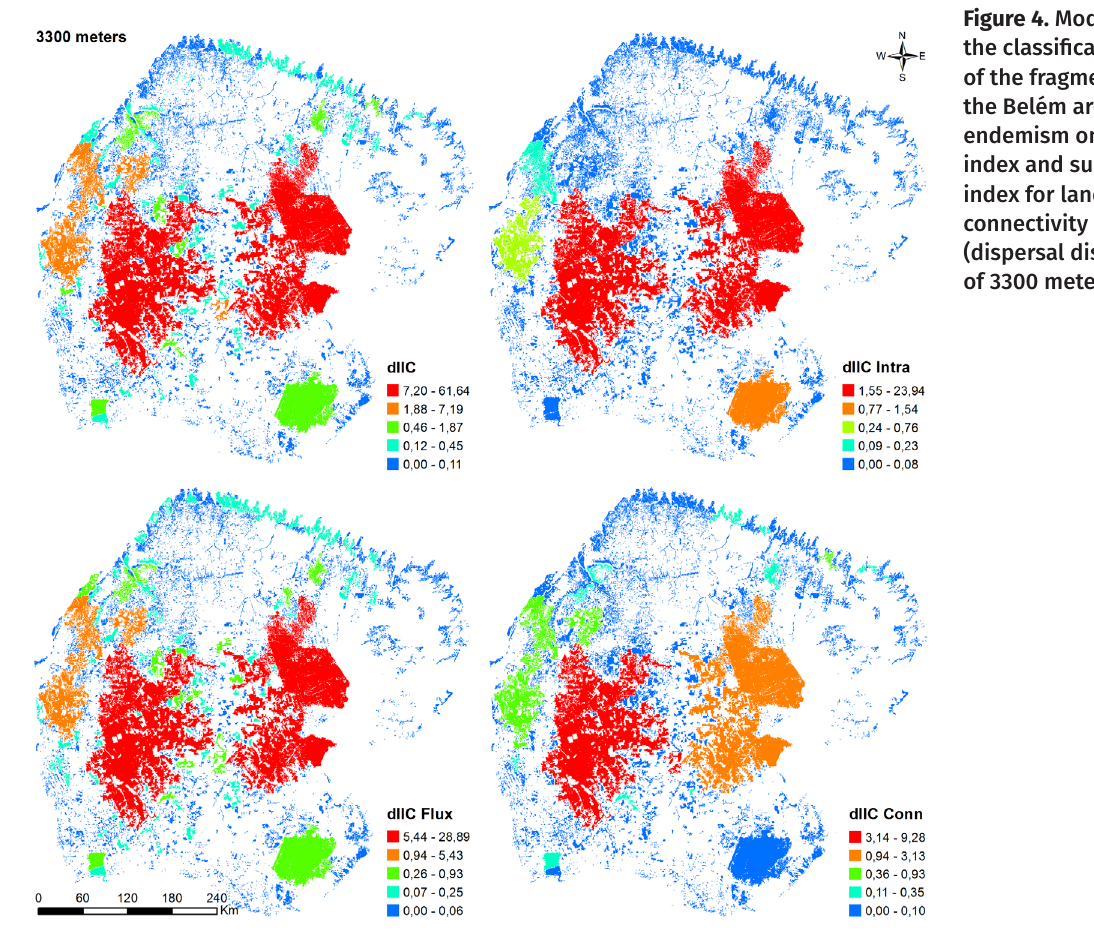
Figure 4. Model with the classification of the fragments of the Belém area of endemism on each index and sub- index for landscape connectivity (dispersal distance of 3300